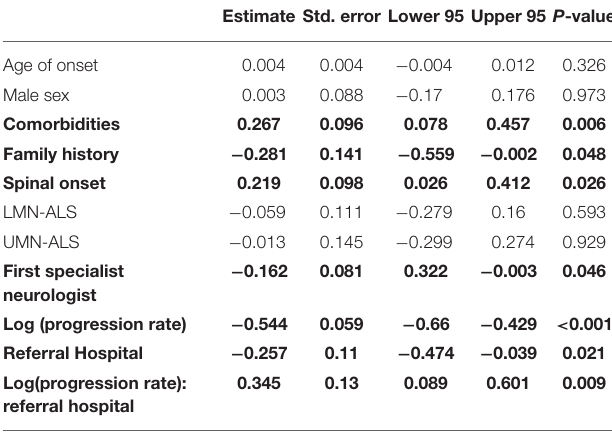
TABLE 4 | Multivariable model assessing the effect of several variables in the diagnostic